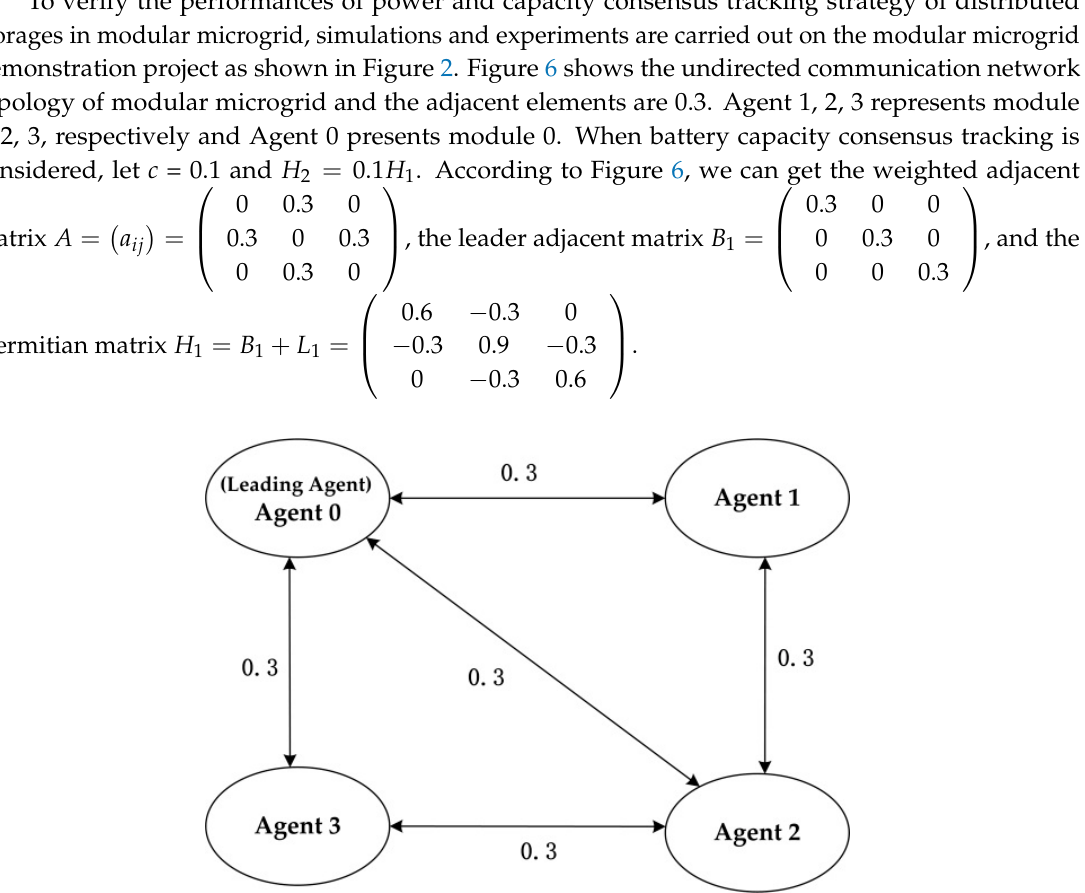
Figure 6. Undirected communication network of modular microgrid.